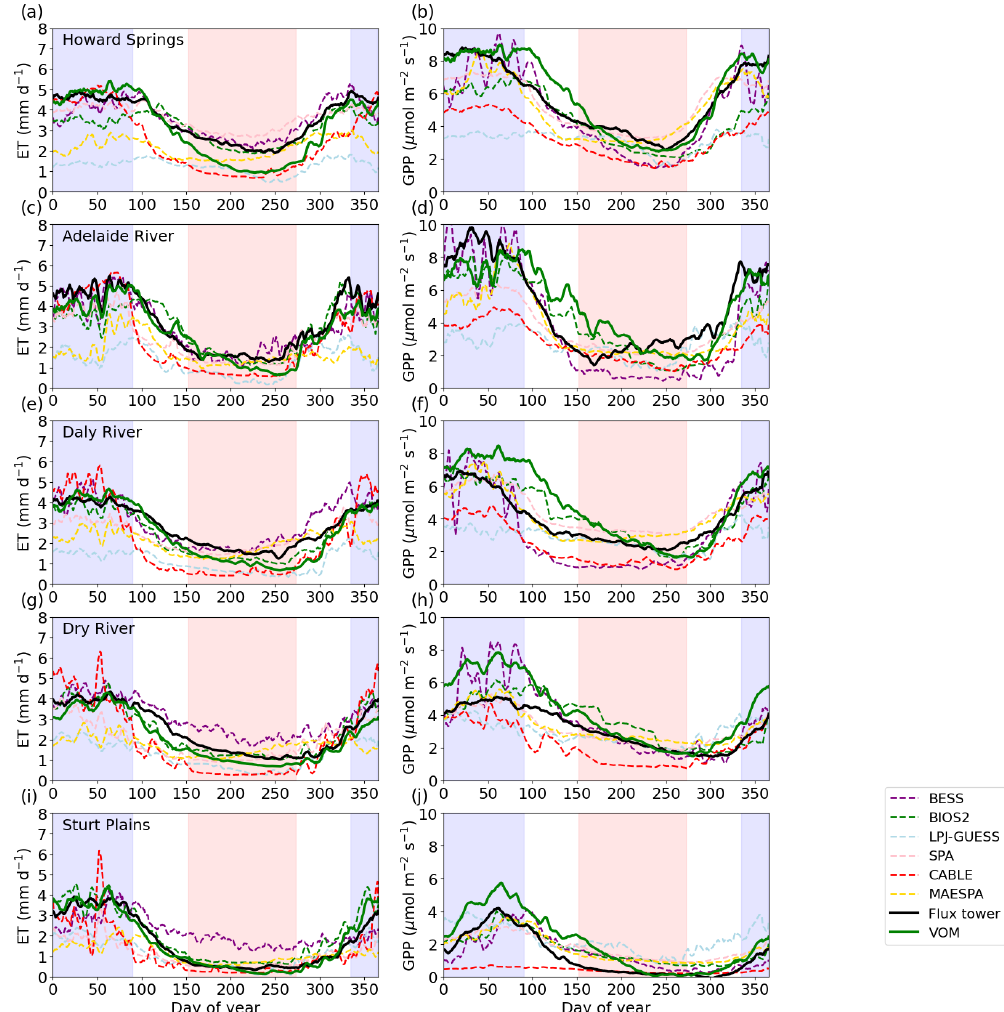
Figure 2. Ensemble years of evapotranspiration (ET) and gross primary productivity (GPP) for the VOM (dark green), flux tower observations (black) and the models BESS (dashed purple), BIOS2 (dashed green), LPJ-GUESS (dashed light blue), SPA (dashed pink), CABLE (dashed red) and MAESPA (dashed yellow) from Whitley et al. (2016), all smoothed by a 7d moving average. The ensemble years are calculated for the overlapping time periods with the flux tower observations (see Table S8.1 in Supplement S8). The dry season (June–September) is indicated by a red shading, the wet season (December–March) by a blue